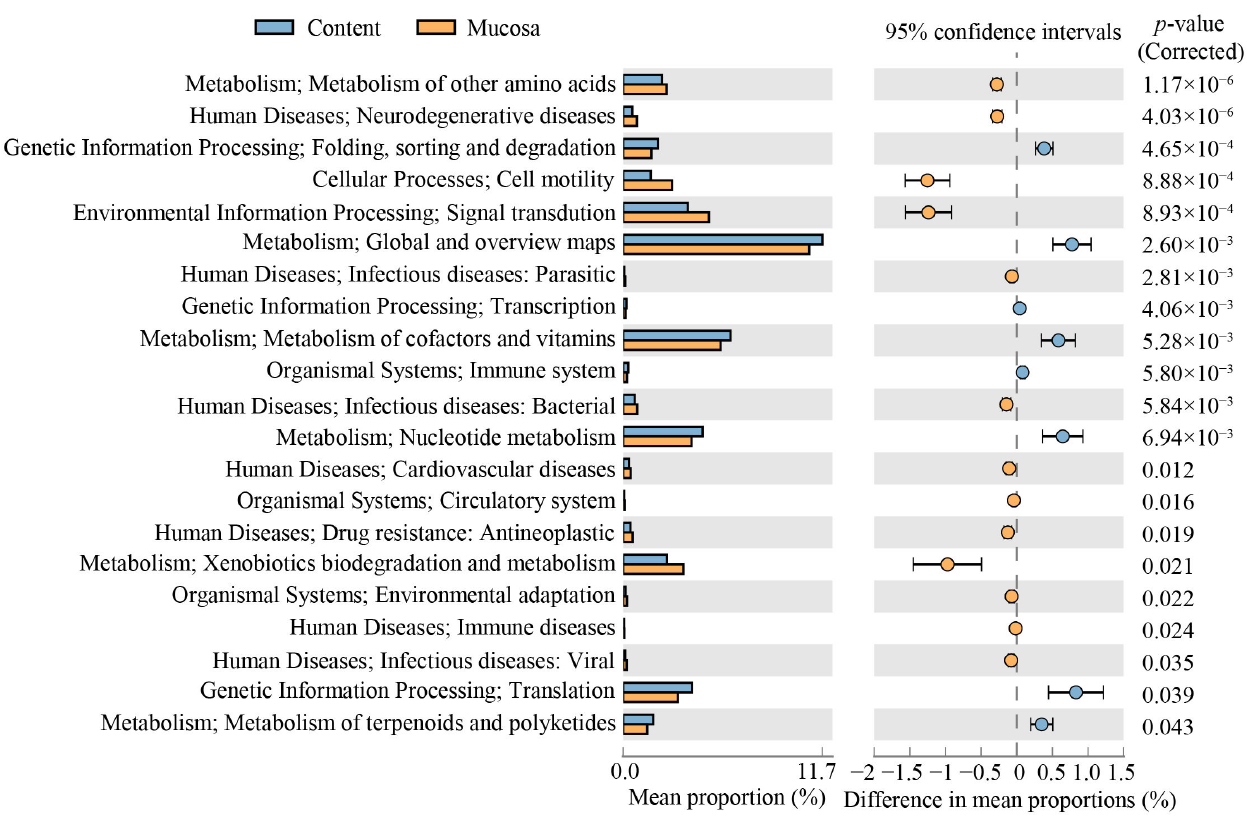
Figure 9. Extended error bar showing the differentiated putative functions of the bacterial communities between the content and mucosa samples as predicted by PICRUSt2 analysis. Rows represent the 21 differentiated KEGG Orthology (KO) functions (corrected p < 0.05), and the bars in the graph represent the mean proportion (%) of the functional categories. The 95% confidence intervals reflect the difference in mean proportions (%), and corrected p -values are displayed on the right of the